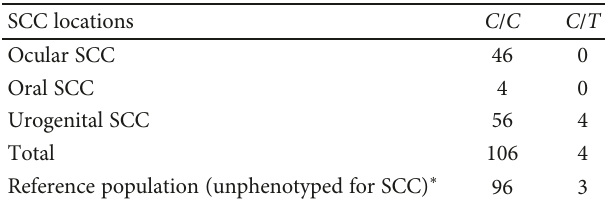
Table 5: DDB2 c.1013 C > T genotypes in SCC phenotyped populations versus an unphenotyped sample set of Appaloosa